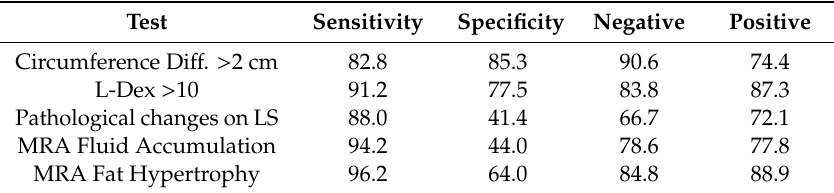
Figure 2. ( A ) Scatter plot of upper extremity limb volume difference (%) distribution by ISL stages. p < 0.05. ( B ) Correlation plot of upper extremity volume measurement using manual vs. perometer techniques. ( C ) Scatter plot of upper extremity volume measurement using manual vs. perometer techniques. ( D ) Correlation plot of upper extremity volume vs. circumference measurement. Table 2. Specificity and sensitivity of assessments for diagnosis of lymphedema (volume di ff erence >